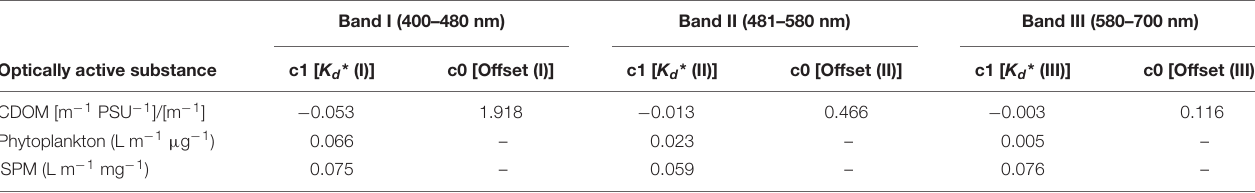
FIGURE 5 | Linear fits between the optically active constituents (CDOM represented by salinity) and their median K d values in the three spectral bands. The solid line represents the linear fit, while the dashed lines give its 95% confidence interval. TABLE 2 | Summary of the substance-specific diffuse attenuation coefficients ( K d *) for different OAS in the trimodal approach.